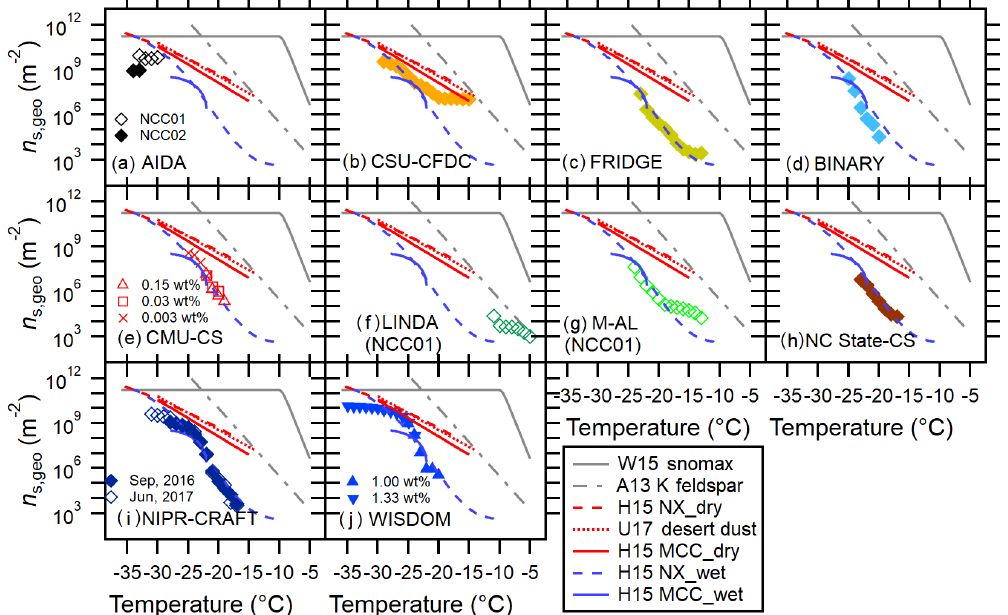
Figure 5. Intercomparison of 11 INP measurement methods for NCC using T -binned n s , geo . Reference immersion freezing n s (T ) spectra are provided as in Fig. 3. Note that unless otherwise specified, the data are for